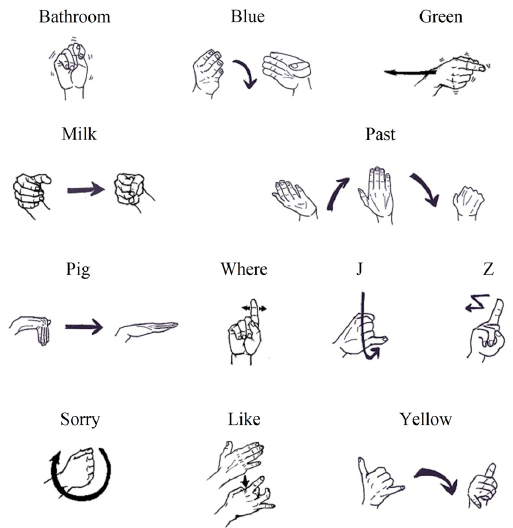
Figure 6. The illustration of twelve gestures of the ASL dataset.